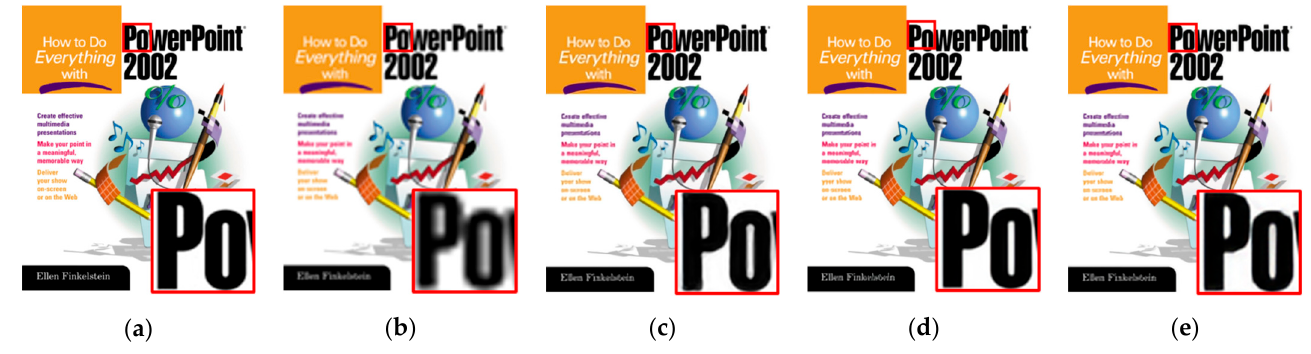
Figure 17. Visual evaluation for a scale factor of 4× on the image “PPT3” from Set14: ( a ) Ground Truth (PSNR, SSIM); ( b ) Bicubic (24.31, 0.7889); ( c ) VDSR (29.93, 0.9344); ( d ) EDSR (31.51, 0.9594); ( e ) Proposed (31.53, 0.9593) .